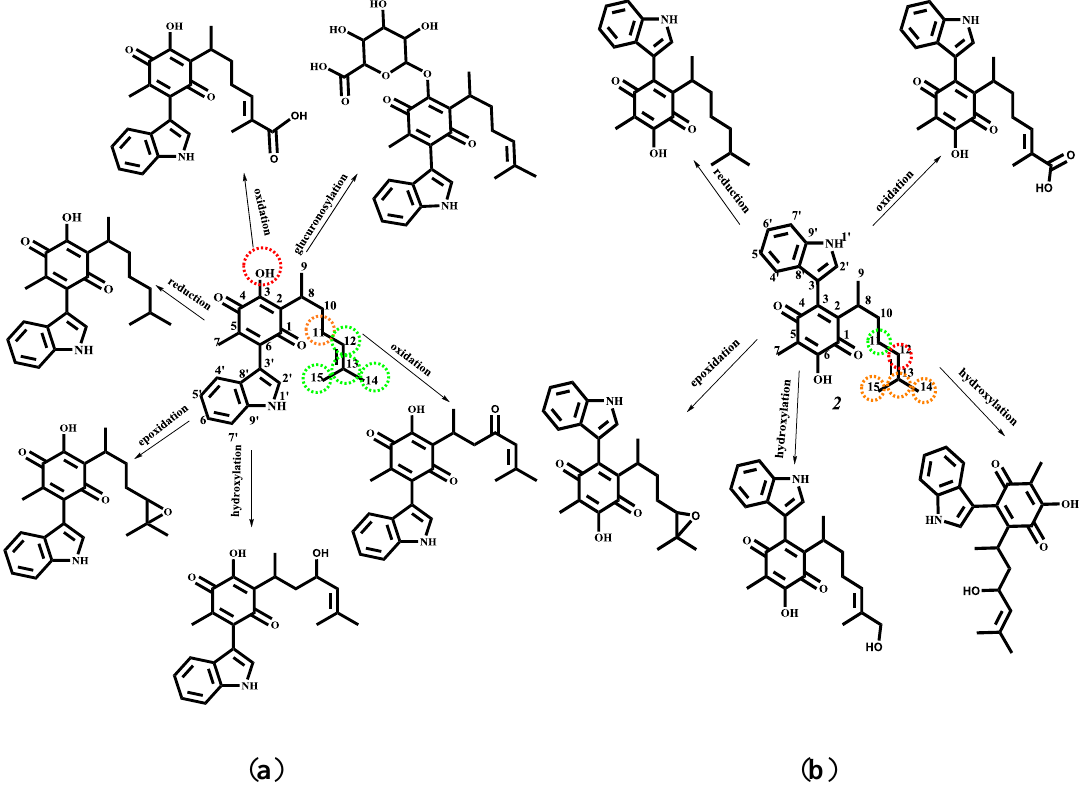
Figure 14. Predicted metabolism for: ( a ) indolylperezone and ( b ) indolylisoperezone.